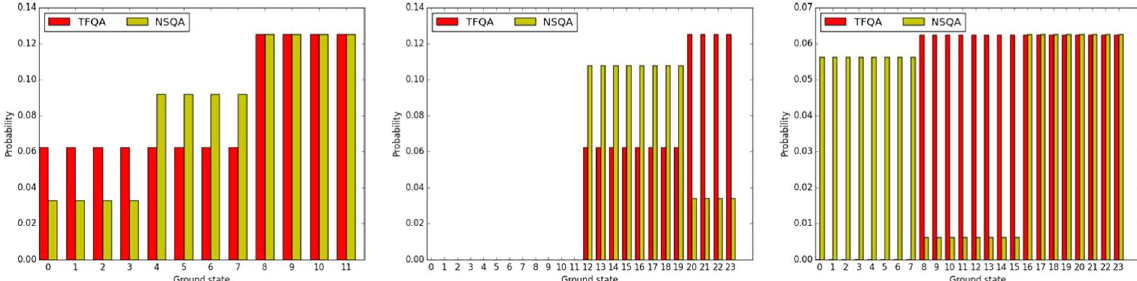
Figure 7. Three sample GSD comparisons between the two drivers: the stoquastic TFQA (red) and non- stoquastic NSQA (yellow). For the instance on the left both drivers sample the ground-state manifold similarly; for the middle instance less probable configurations for one method become more probable in the other and vice versa; on the right, we find an instance for which states with zero probability of occurring with one type of quantum fluctuations have distinct positive probabilities of occurring in the other.